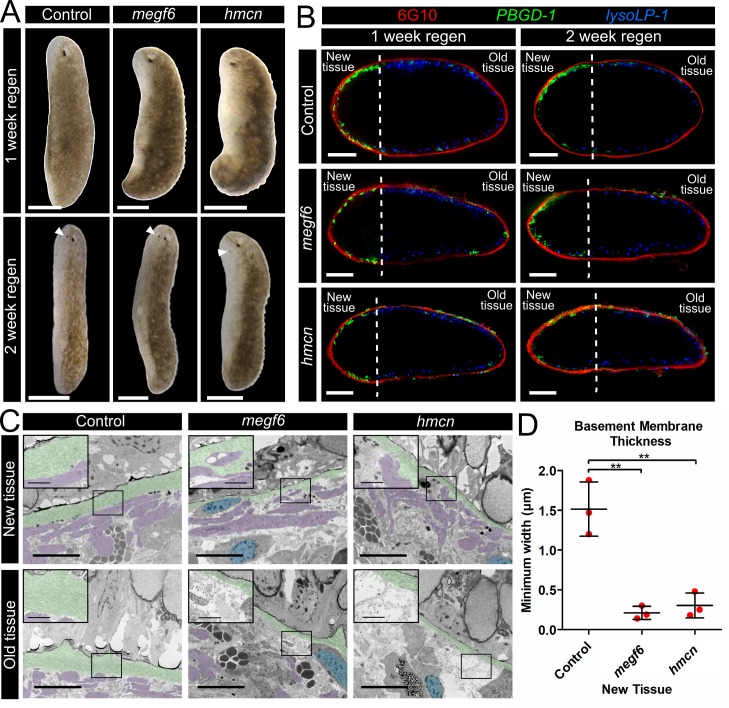
Tissue defects do not appear in newly regenerated tissue.A) Live images of regenerating control, megf6, or hemicentin knockdown planarians 1 or 2 weeks after a sagittal amputation (n ≥ 4). White arrows mark the regenerating eyespots at 2 weeks post amputation. B) Cross-sections of worms amputated as shown in A). Worms were stained with double FISH for PBGD-1 and LysoLP-1, and immunostained with 6G10 (n ≥ 6). Amputation planes are marked with dotted lines. C) Transmission electron microscopy of the subepidermal region of worms amputated as shown in B) and regenerated for 1 week. The basement membrane is coloured green, subepidermal nuclei are blue, and muscle fibers are purple. Black boxes denote the magnified region, shown in the top left corner of each panel. D) Quantification of basement membrane width as visualized in D), measured at the thinnest point in the new tissue of control and knockdown planarians (n = 3). Scale bars: 250 μm in A; 100 μm in C; 5 μm in main panels and 1 μm in insets in D. Error bars are standard deviations. **p < 0.01 (Welch’s t-test).